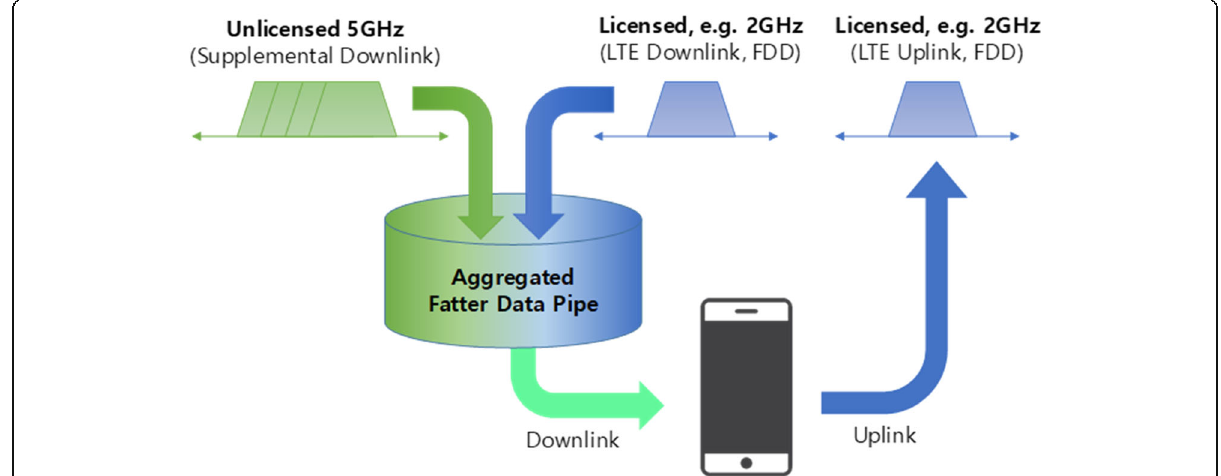
Fig. 1 Band aggregation of LTE-LAA